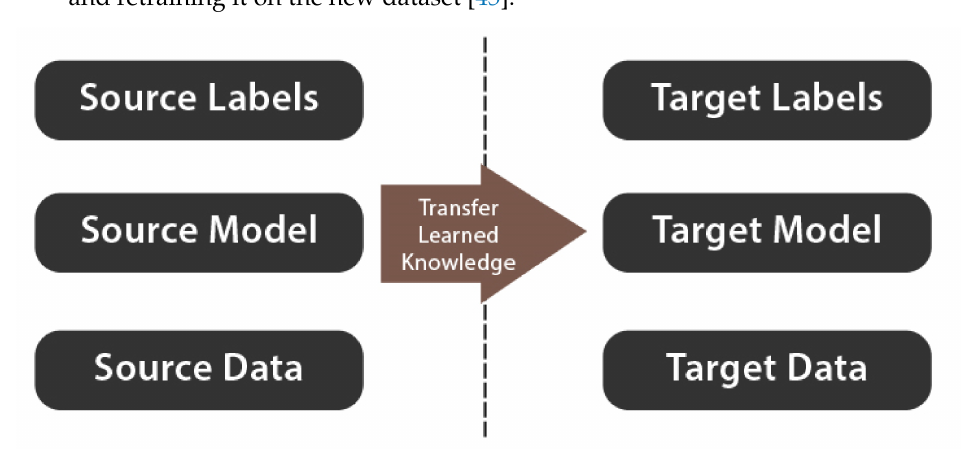
Figure 7. Transfer Learning